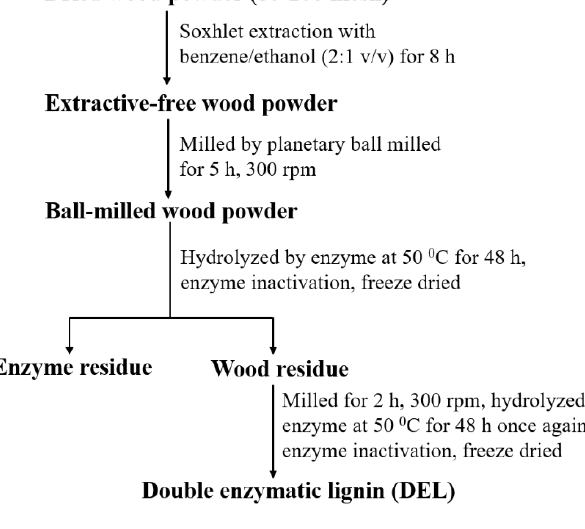
Figure 1. Isolation process of DEL from Chinese fir and birch.